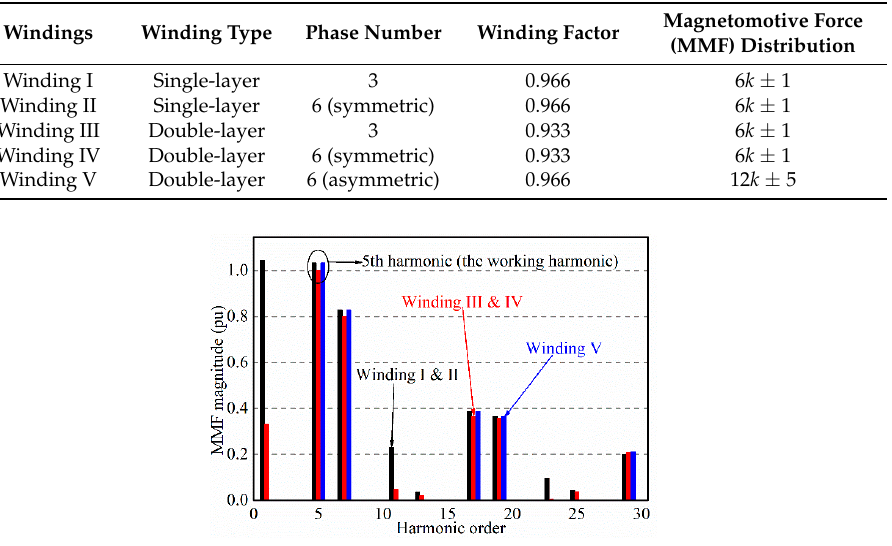
Figure 1. Different winding configurations for the 12-slot/10-pole configuration: ( a ) Three-phase winding with single layer (Winding I); ( b ) Symmetric six-phase winding with single layer (Winding II); ( c ) Three-phase winding with double layer (Winding III); ( d ) Symmetric six-phase winding with double layer (Winding IV); ( e ) Asymmetric six-phase winding with double layer (Winding V). Table 1. Comparison of different winding layouts for the 12-slot/10-pole configuration.